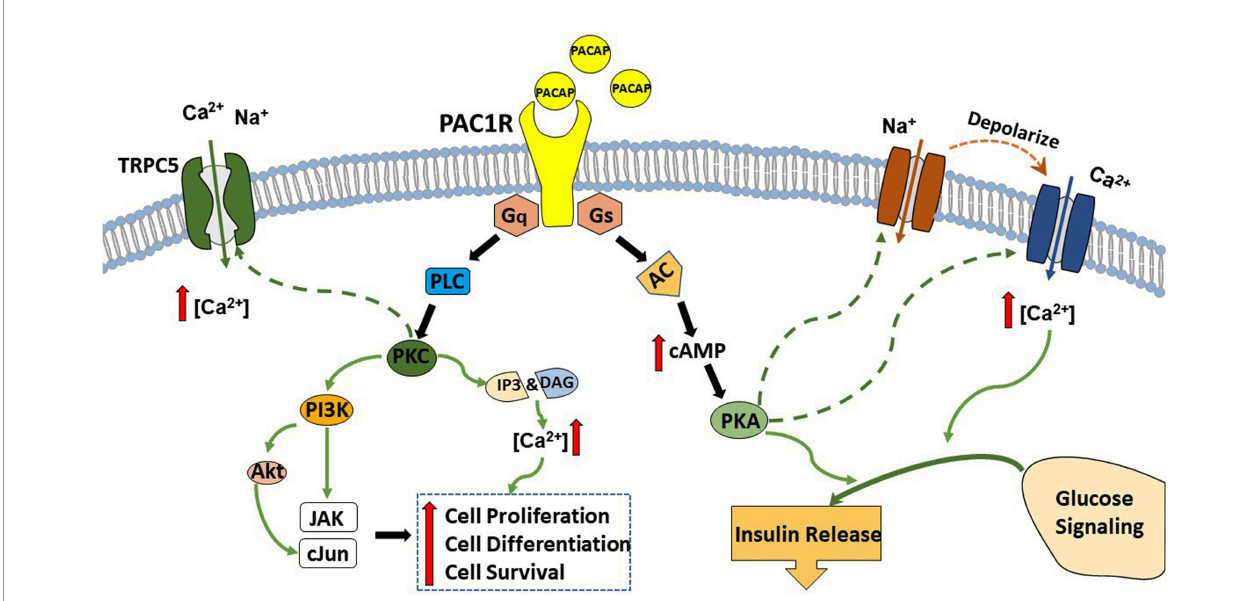
FIGURE 2 | A schematic summary of PACAP signaling cascades. PACAP exerts its effects via interaction and activation of the PAC1 receptor. This receptor couples to both G s and G q . Upon PAC1 receptor stimulation activation of G s and subsequently adenylyl cyclase (AC) triggers the production of cyclic adenosine monophosphate (cAMP), which augments protein kinase A (PKA) phosphorylation and feeds into glucose signaling and insulin release. In contrast, the coupling with G q activates phospholipase C (PLC) and boosts the production of inositol triphosphate (IP) 3 and diacylglycerol (DAG), which leads to the activation of protein kinase C (PKC) and increases intracellular Ca 2+ to promote cell survival, cell proliferation, and cell